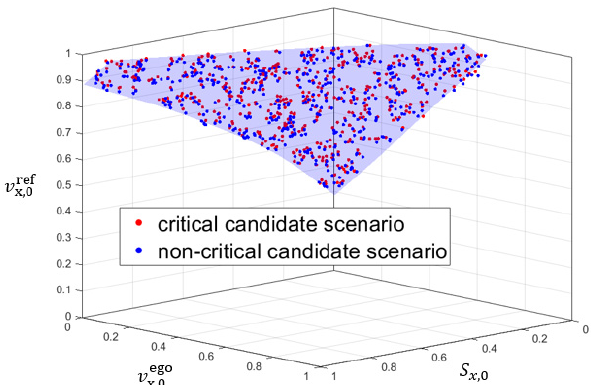
Figure 11. Candidate scenarios detected based on GGPC and their fitting surface. Red circles are critical scenarios, while blue circles are non-critical scenarios. In addition, the semi-transparent blue surface is the performance boundary.